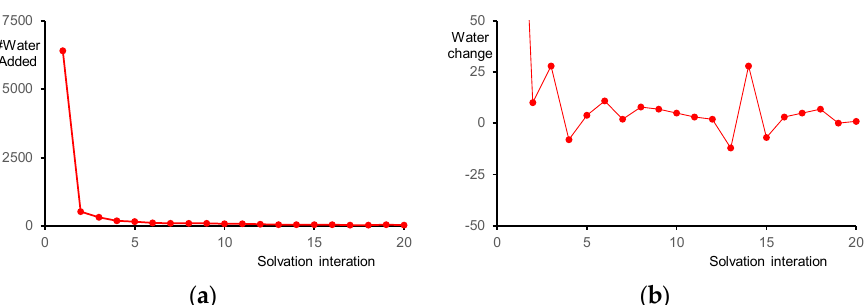
Figure 7. ( a ) Iterative solvation procedure during the set-up of wildtype Compound I structure of P450 OleT JE with number of water molecules added per solvation step. ( b ) Change in the number of water molecules from one solvation step to the next.